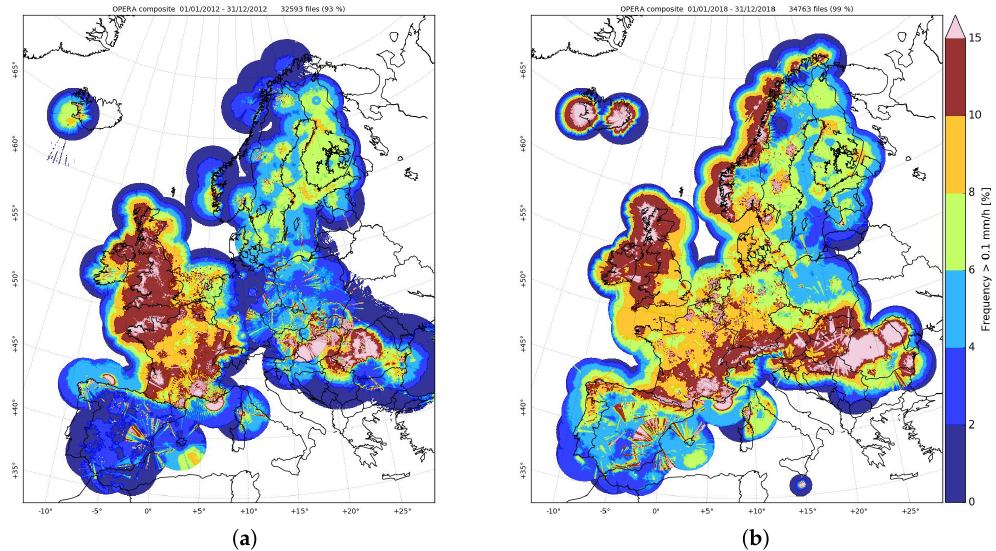
Figure 5. Frequency of precipitation over 0.1 mm/h in ( a ) 2012 and ( b ) 2018.